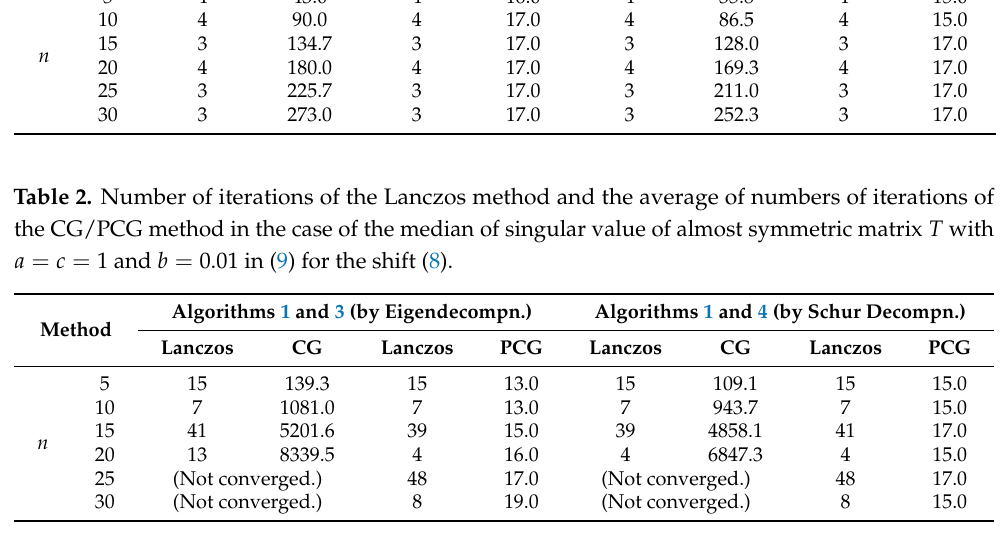
Table 3. Number of iterations of the Lanczos method and the average of numbers of iterations of the CG/PCG method in the case of the 5-th min. singular value of almost symmetric matrix T with a = c = 1 and b = 0.01 in (9) for the shift (8). Algorithms 1 and 3 (by Eigendecompn.) Method